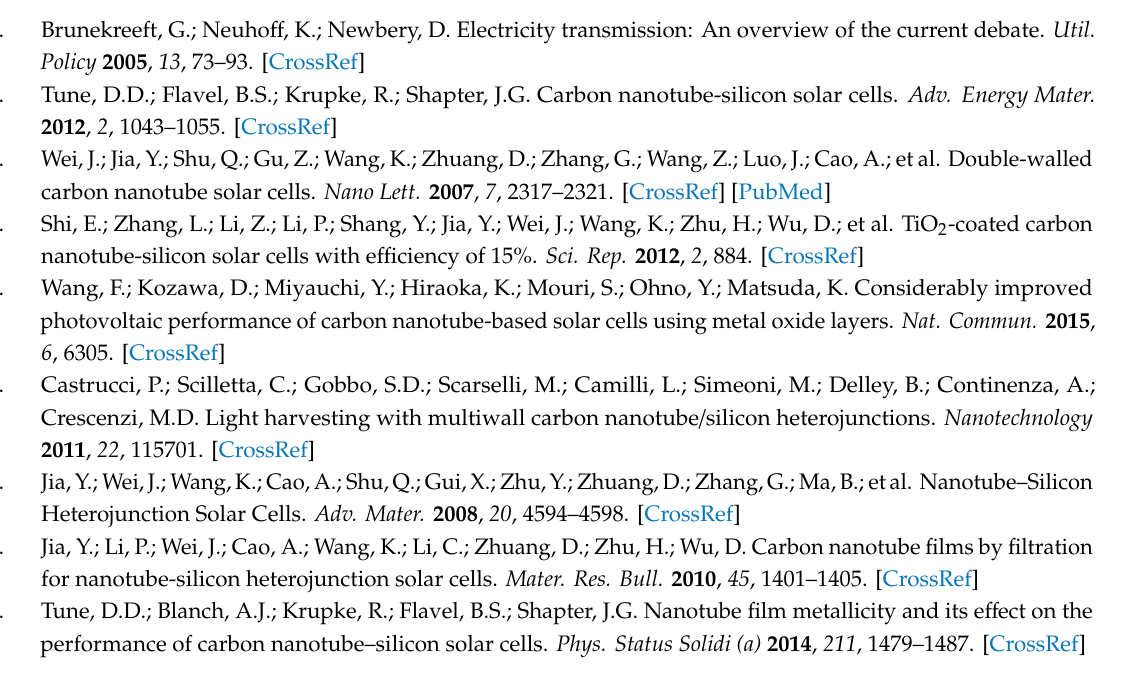
Figure S1: The absorption spectrum for the 300 µ L SWCNTs-dispersion. Figure S2: Dark curves for the SWCNTs-n-Silicon based solar cell at di ff erent stages of treatment made using 300 µ L of the SWCNT dispersions. Figure S3: Light curves for the SWCNTs-n-Silicon based solar cell at di ff erent stages of treatment made using 300 µ L of the SWCNT dispersions. Table S1: The cell parameters for the reference SWCNTs-n-Si solar cell made with 300 µ L of SWCNT dispersion. Figure S4: Light curves for the cells made with MoS 2 / SWCNT hybrid films of various thicknesses. Table S2: The cell parameters for devices made with MoS 2 / SWCNT hybrid films of various thicknesses. Figure S5: Light curves for the SWCNTs-n-Silicon reference solar cell and cells made with MoS 2 / SWCNT hybrids after various HF etching times. Table S3: Parameters for the reference SWCNTs-n-Si solar cell made with 300 µ L SWCNT dispersion and cells made with MoS 2 / SWCNT hybrids after various HF etching times. Figure S6: Light curves for the SWCNTs-n-Silicon reference solar cell and cells made with MoS 2 / SWCNT hybrids using various ratios of dispersions. Table S4: The cell parameters for the reference SWCNTs-n-Si solar cell and cells made with MoS 2 / SWCNT hybrids using various ratios of dispersions. Figure S7: Light curves for the cells made with a layer structure with the Si first covered a MoS 2 layer, which is then covered by a SWCNT layer. Table S5: The parameters for cells made with a layer structure with the Si first covered a MoS 2 layer, which is then covered by a SWCNT layer. Figure S8: Representative light curves for the best average cells. Table S6: The parameters for the best average